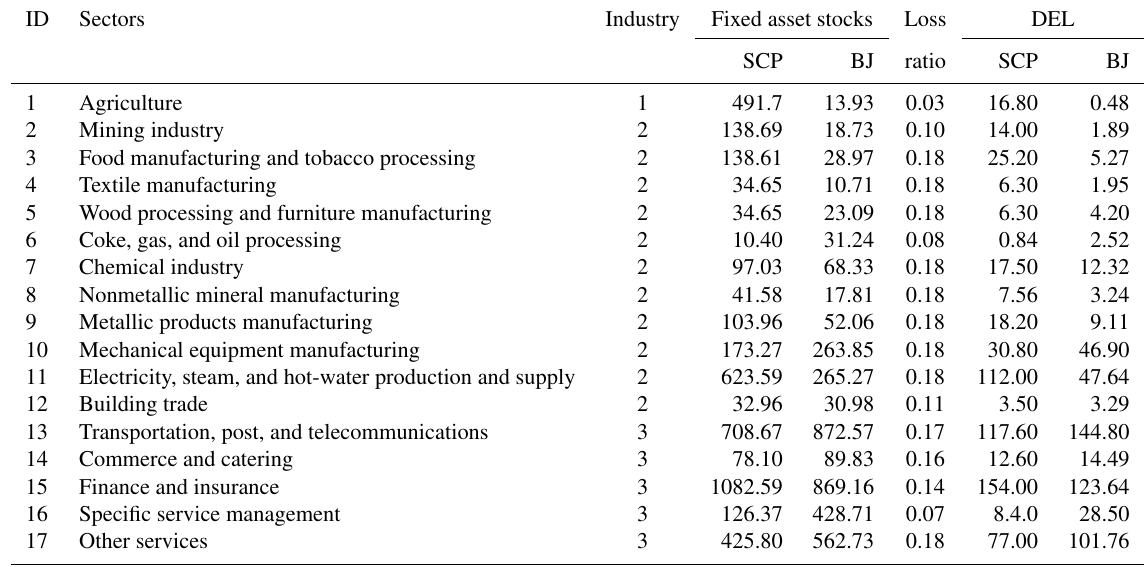
Table 1. Calculation results of the stock of fixed assets and the direct economic loss of BJ and SCP. ID